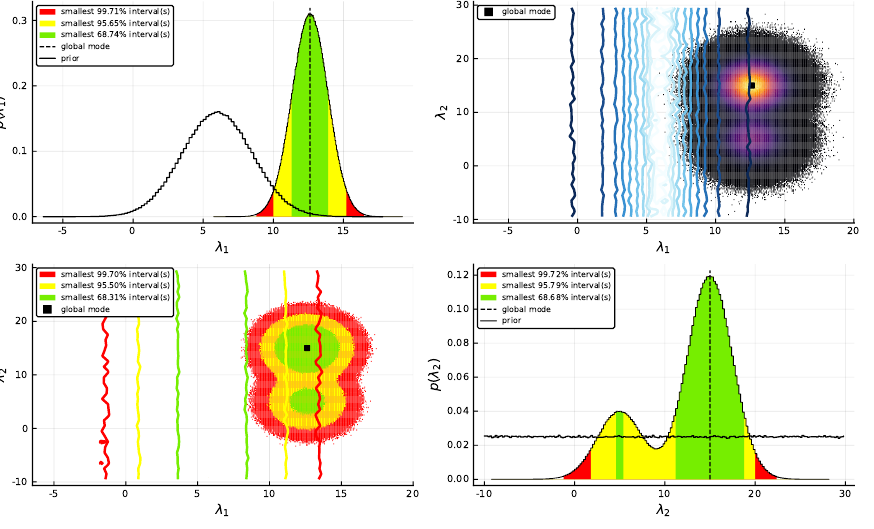
Figure 1. Plots visualizing the posterior samples together with the prior distribution as marginalized 1D and 2D histograms. The smallest intervals containing 68 . 3%, 95 . 5% and 99 . 7% are highlighted. The global mode is